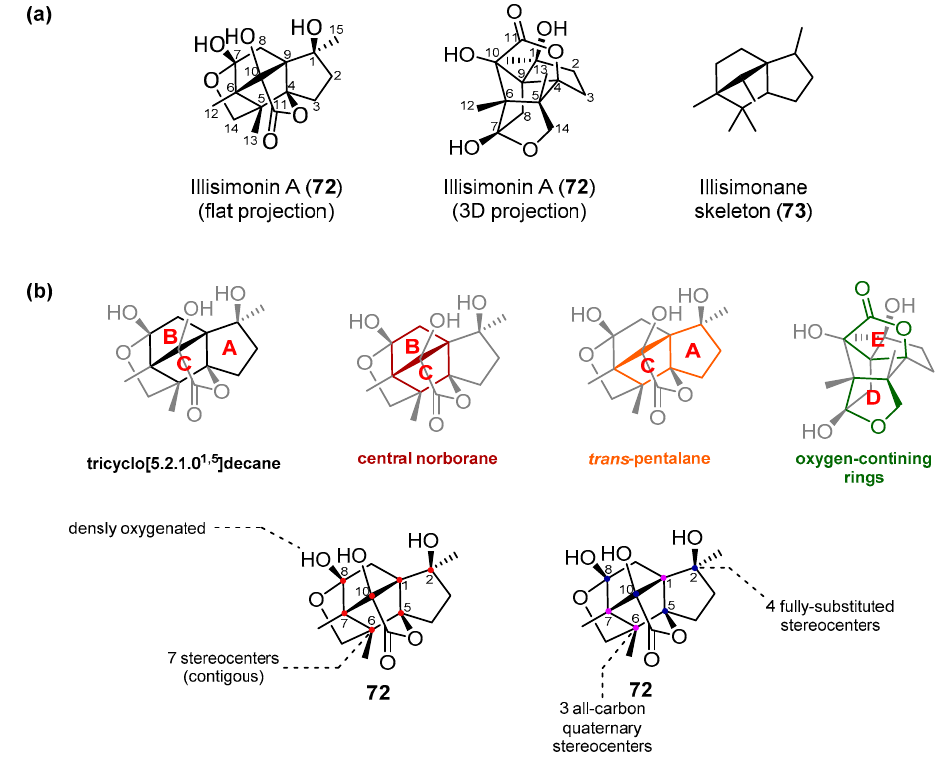
Figure 7. ( a ) Structure of illisimonin A ( 72 ) in flat and three-dimensional projection, and representation of the illisimonane carbon skeleton ( 73 ); ( b ) ring systems and stereogenic centers of illisimonin A ( 72